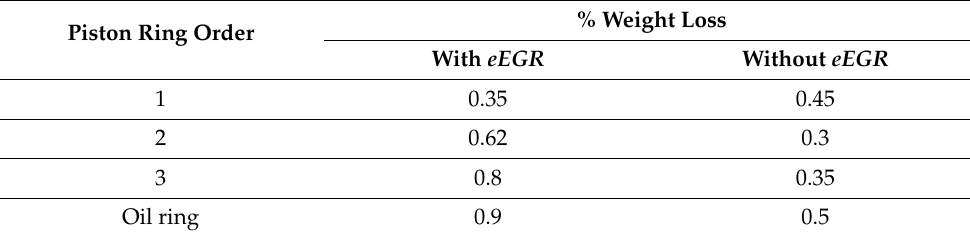
Table 1. Effect of eEGR on piston ring wear.